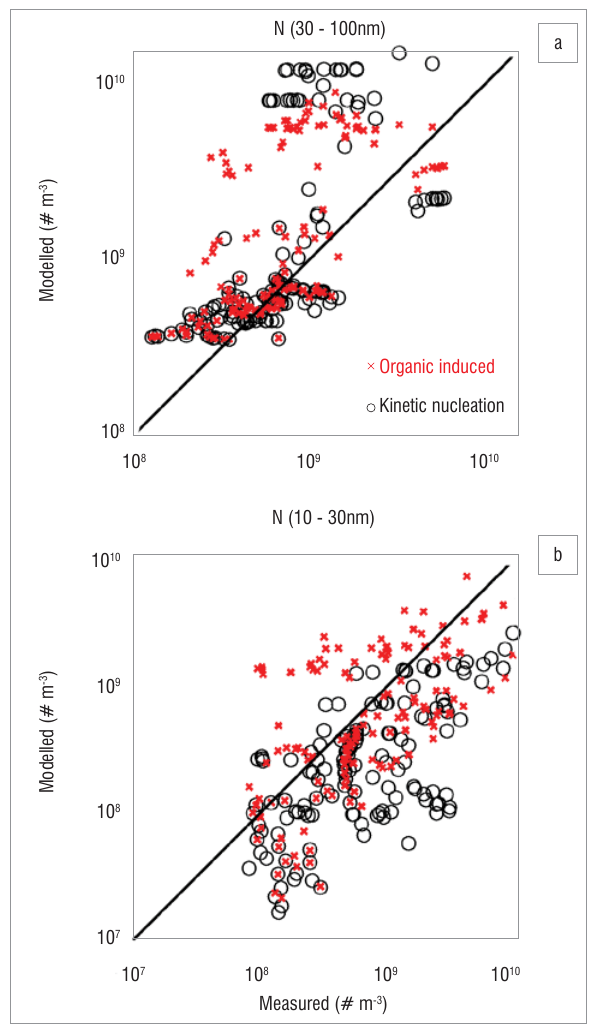
Figure 8: Modelled 1-h averages of number concentrations against measured for (a) 30–100-nm and (b) 10–30-nm particles, including all studied days. Results from simulations with organic-induced nucleation are shown with crosses (x) and kinetic nucleation with circles ( ○ ), and are from a model height of 4.0